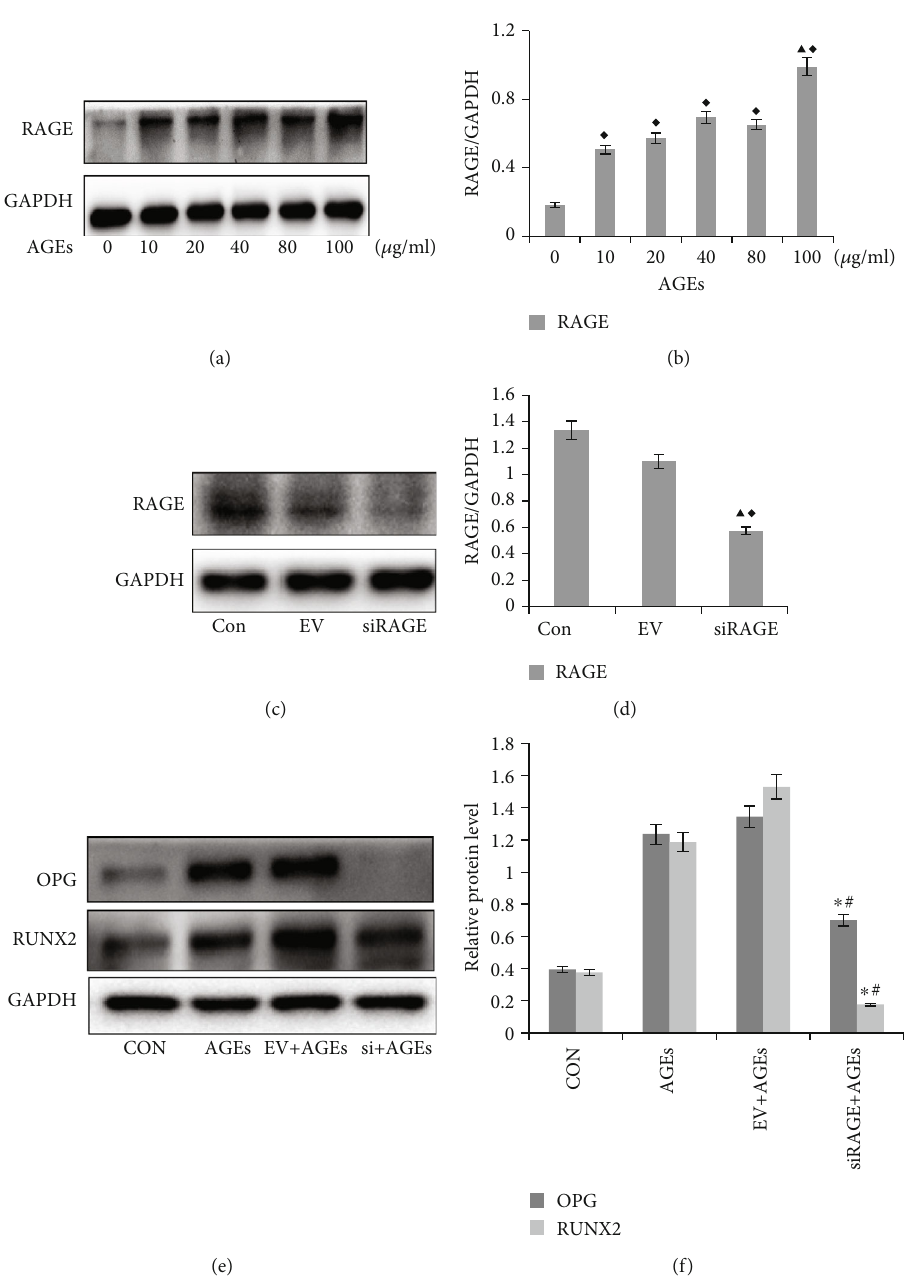
Figure 5: siRAGE transduction reduces the AGE-induced increase in RAGE expression in EPCs and reduces the expression levels of calci fi cation-related proteins in EPCs. (a) Representative western blotting images and densitometric analysis of RAGE protein expression in EPCs stimulated with the indicated concentration of AGE for 7 days. (c) RAGE protein expression levels were detected and semiquanti fi ed using western blotting in the EPCs induced by 100 μ g/ml AGE for 7 days, after transfection with siRAGE, EV, or treatment with PBS as the control. (e) EPCs were transfected with siRAGE, empty vector (EV-AGEs), or control (EGM-2MV) then induced with 100 μ g/ml AGE for 7 days. Cells not treated with AGEs were used as the controls. Expression levels of cellular calci fi cation- related proteins OPG and RUNX2 were detected by western blotting. GAPDH was used as the loading control. Each data point represents the results of three independent assays. Comparison with control, ▲ P < 0 : 05 vs.; AGEs 100 mg/ml compared with other groups; ◆ P < 0 : 05 vs.; comparison with AGEs alone, ∗ P < 0 : 05 vs.; comparison with EV-AGEs, # P < 0 : 05 vs. AGE: advanced glycation end product; EPC: endothelial progenitor cell; EV: empty-vector – transfected control group; OPG: osteoprotegerin; RUNX2: runt-related transcription factor 2; siRAGE: small interfering RNA against receptor for